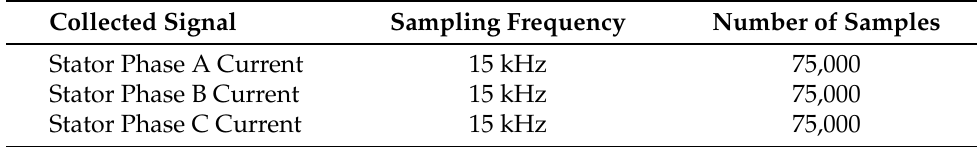
Table 2. Signal Acquisition Parameters.